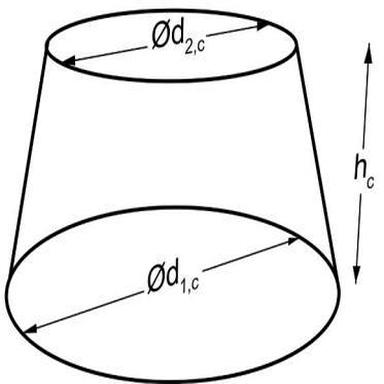
Definition of internal truncated cone dimensions.